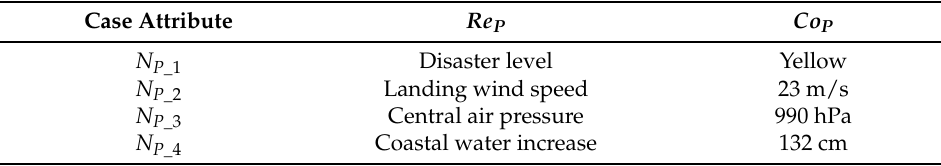
Table 6. Label information V P of storm surge disaster case no.